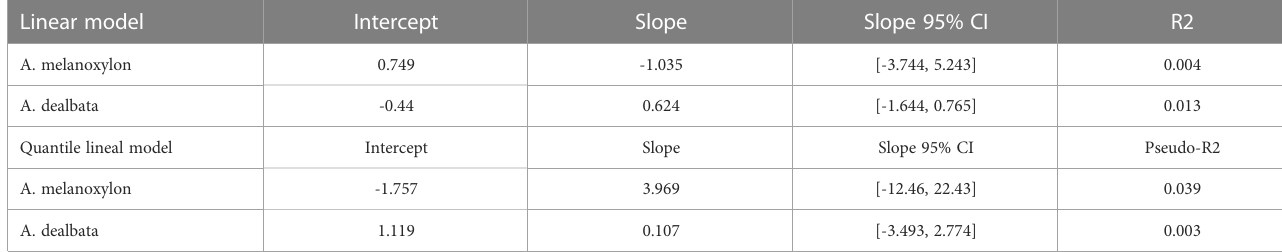
TABLE 4 Results for simple lineal and quantile lineal models for the relationship between sustainability and tree growth for both Acacia species. Linear